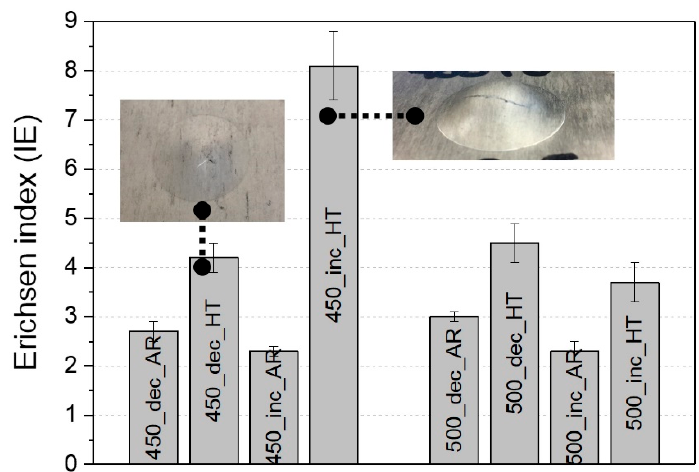
Figure 7. Erichsen index of the differently rolled and annealed sheets and appearances of the Erichsen samples of the 450-dec and 450-inc sheets (inset).